Question: What visual encoding does this figure use to show its data?
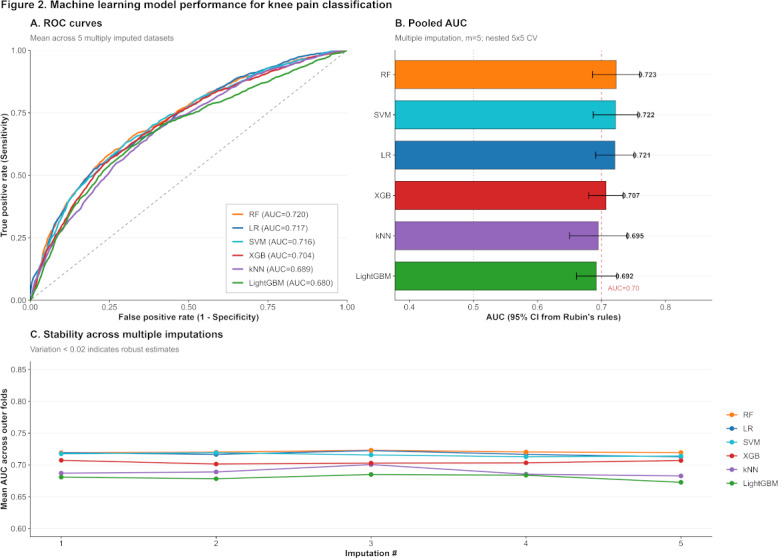
Answer: line